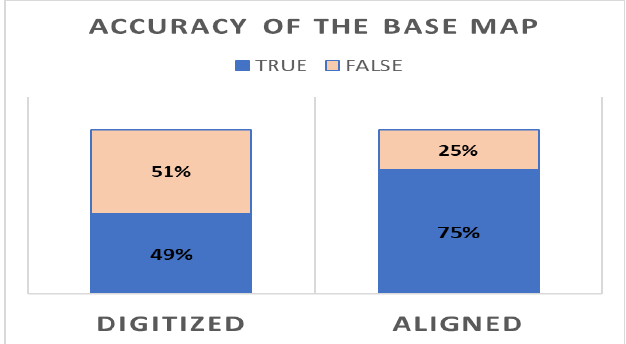
Fig. 8. Improvement of the accuracy after